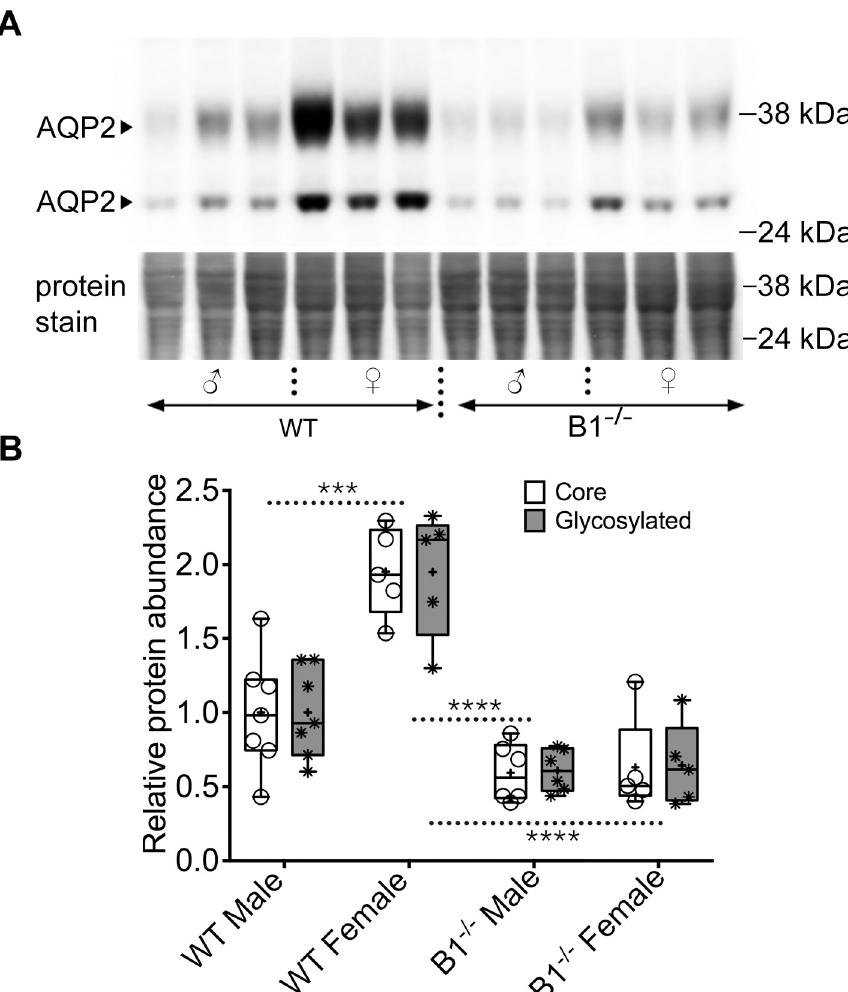
Fig 3. Total AQP2 protein expression in male and female WT and Atp6v1b1-/- animals. (A) Immunoblot showing the two characteristic, core and glycosylated, bands of AQP2 in the top panel. The bottom panel shows the loading control using total protein stain with the Pierce Reversible Protein Stain kit. (B) Lane intensity quantification normalized to the protein loading control shows that at baseline, WT females had the highest total AQP2 and deficiency in B1 subunit of the V-ATPase reduces total AQP2, especially in the female animals. There was also a reduction in total protein in the B1 -/- male animals compared to their WT counterparts, though within our tested experimental conditions it was not statistically significant. Deficiency in the B1 subunit in female animals reduced the total protein content to such an extent that it became comparable to the level of protein in male animals of both